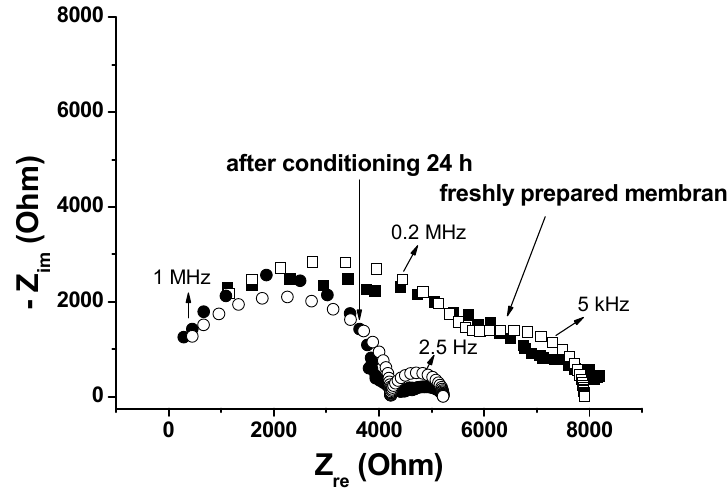
Figure 7. Nyquist plot for the freshly prepared membrane and for the conditioned membrane; the open symbols represent the fit of the experimental data, based on the electrical circuit presented in Figure